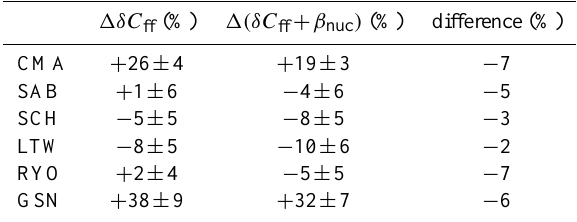
Table 1. Change in simulated δC ff and δC ff + β nuc between 5-yr means for 1985–1989 and 2001–2005 at the sites shown in Fig. 4. Uncertainties were calculated using the standard error in simulated δC ff and δC ff + β nuc over the 5-yr periods, which comprise only variations in emissions and atmospheric transport over the 5-yr pe- riods. Uncertainties in 14 C emission factors are not